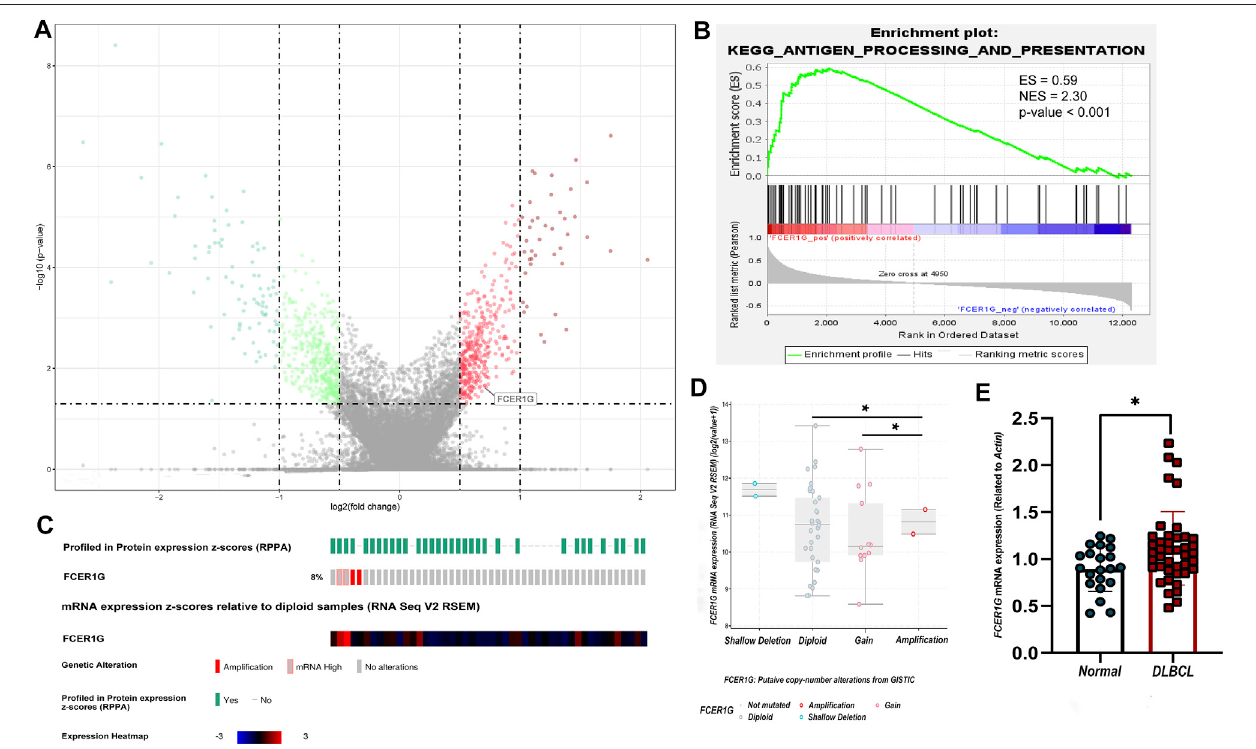
FIGURE 9 | The expression, pathway enrichment and mutation landscape of the fi nal hub gene (A) The volcano plot with differentially expressed genes. Red dots indicated overexpression genes, green dots exhibited the low expression genes, and the grey boxed represented meaningless expression genes. (B) KEGG pathway analysisofthepositiveregulation ofFCER1G. (C) Theheatmap ofFCER1G mRNA expression and the genetic alteration inthe TCGA-DLBC dataset. (D) Comparison of FCER1G expression between different types of copy number variation groups. (E) Validation of mRNA expression ofthe fi nal keygene FCER1G related with CD4 + T cells in fi ltration degree in FFPE samples ( p -value =